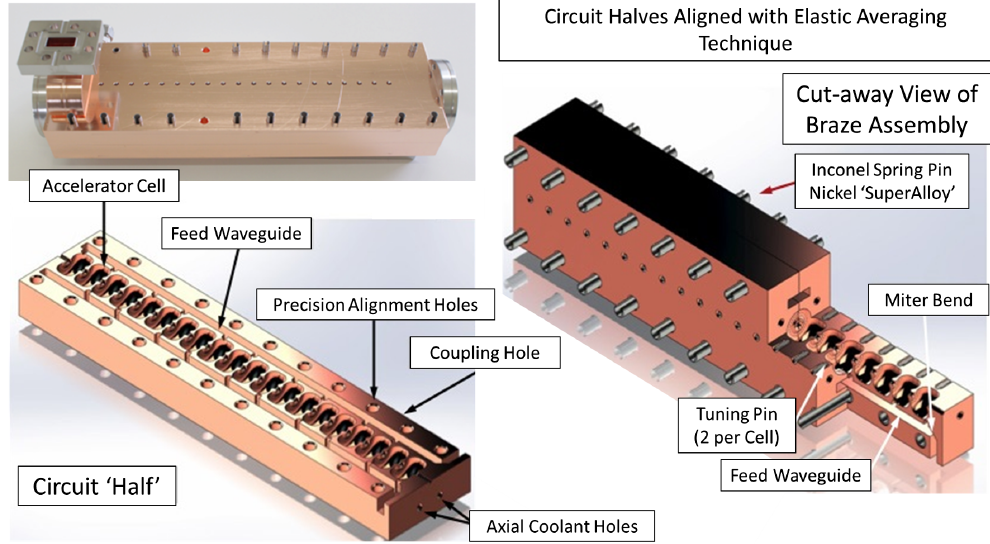
FIG. 7. Illustration of the manufacturing of the distributed-coupling linac from two quasi-identical copper blocks including the tuning pins, alignment holes, and cooling channels.